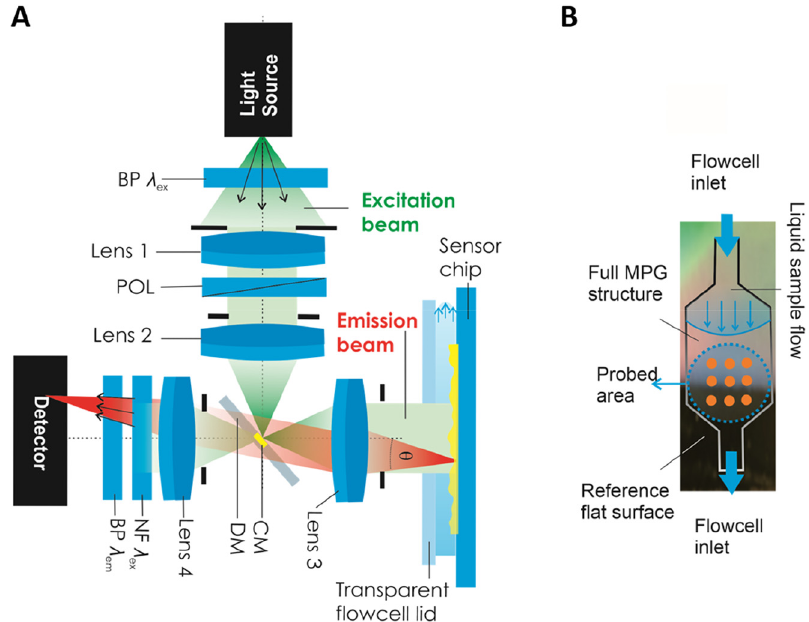
between the original baseline and after the 5 min slow decrease in the fl uorescence signal occurs due to rinsing. The measured data show that the MPG dissociation of af fi nity bound molecules. The irradia- structure enhanced the fl uorescence sensor response tion power at λ was selected to prevent the fl uo- ex by a factor of 292 with respect to the fl at surface, rophore labels from bleaching within the reaction time. The sensor response Δ F to the analyzed sample formed without the kinetics readout (see Figure 5). was de fi ned as a difference in the fl uorescence signal